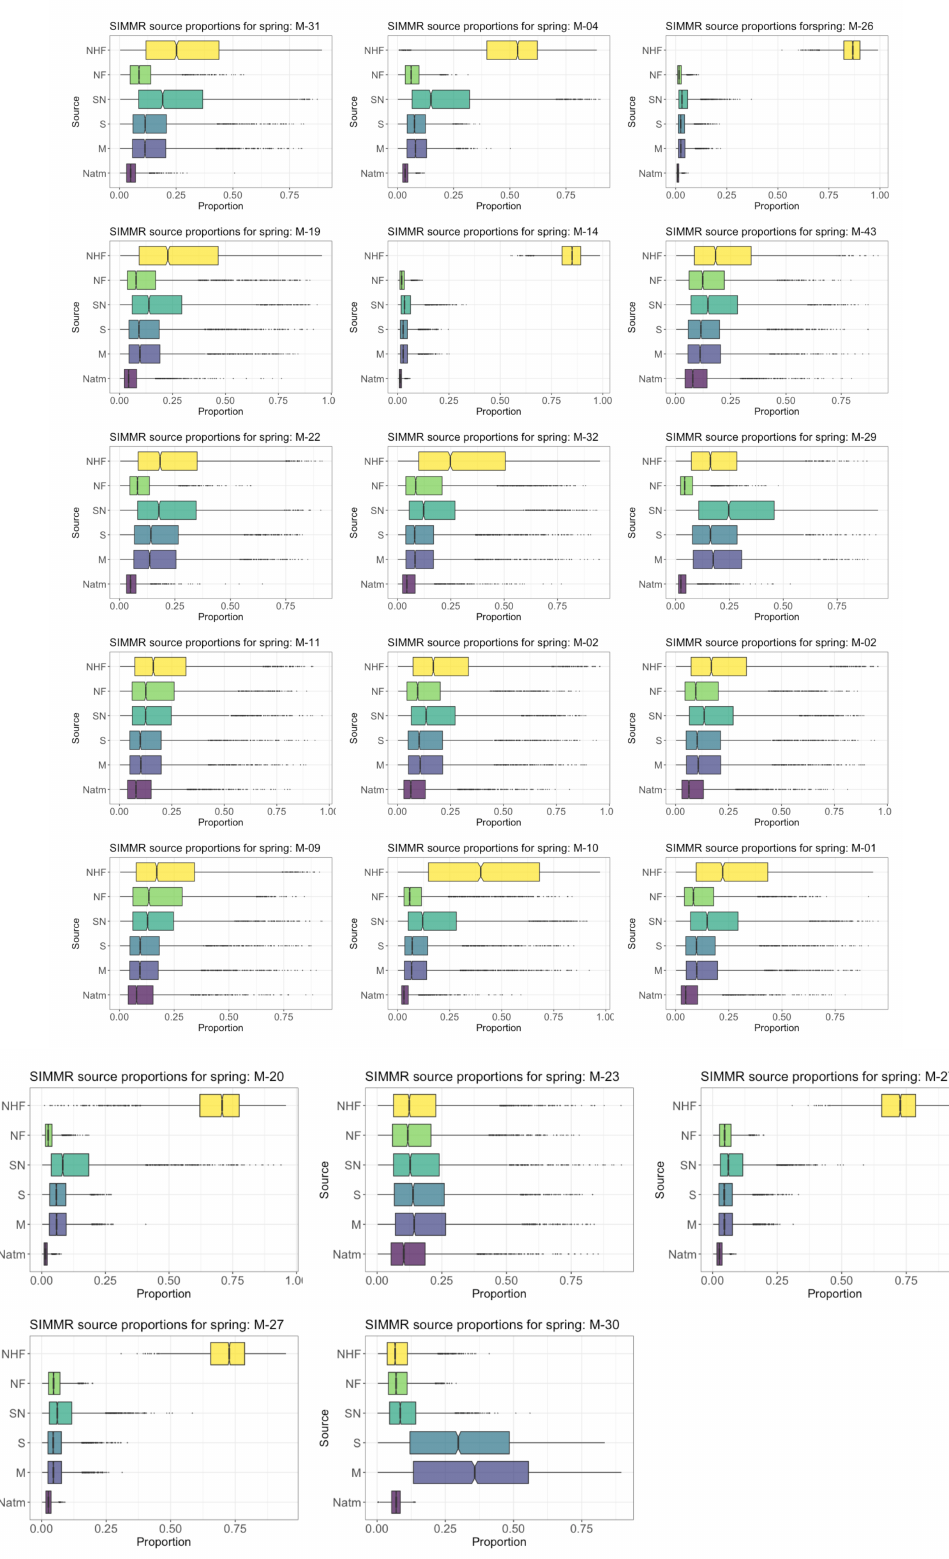
Figure A6. Bayesian isotope mixing model outputs for NO3 for all 20 springs. The considered sources are the same as the biplots (Figure 12A) plus atmospheric deposition: (NHF) NO 3 − derived from NH 4 + in chemical fertilizer and precipitation; (NF) NO 3 in chemical fertilizer; (SN) Soil organic nitrogen; (S) soil; (M) manure; (Natm) atmospheric deposition. In total, 72 samples that were averaged from 20 springs were available of the 43 springs in total. No samples could be prepared for the remaining 23 springs corresponding to those with lower concentrations of